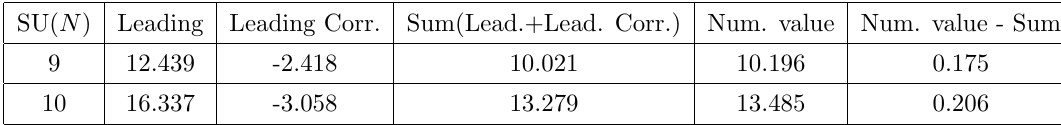
N 10). (cid:20) (cid:20)